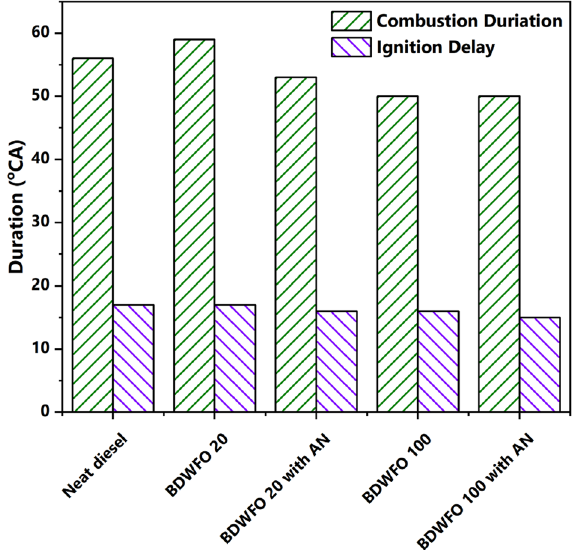
Figure 8. Variation of combustion duration and ignition delay for various fuel blends.